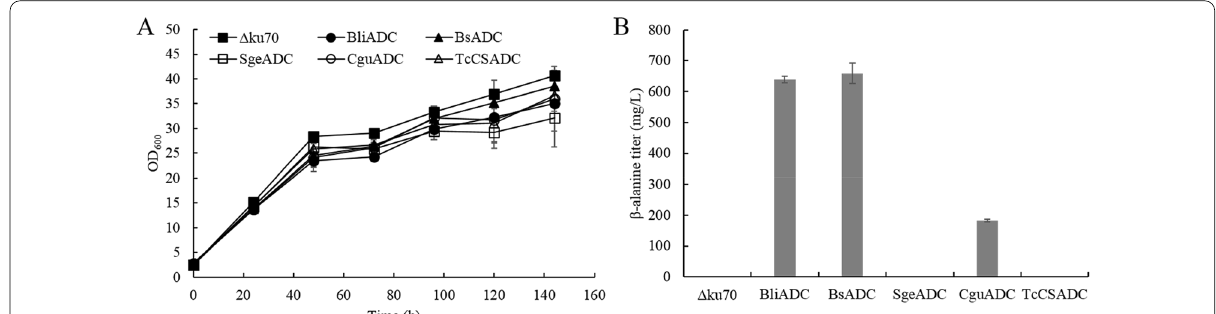
Fig. 2 Overexpression of ADCs from different sources for β-alanine synthesis. A Growth profiles of recombinant strains; B β-alanine production in recombinant strains at the end of fermentation. Three parallel flasks are tested for each strain. Error bars represent deviations ( n